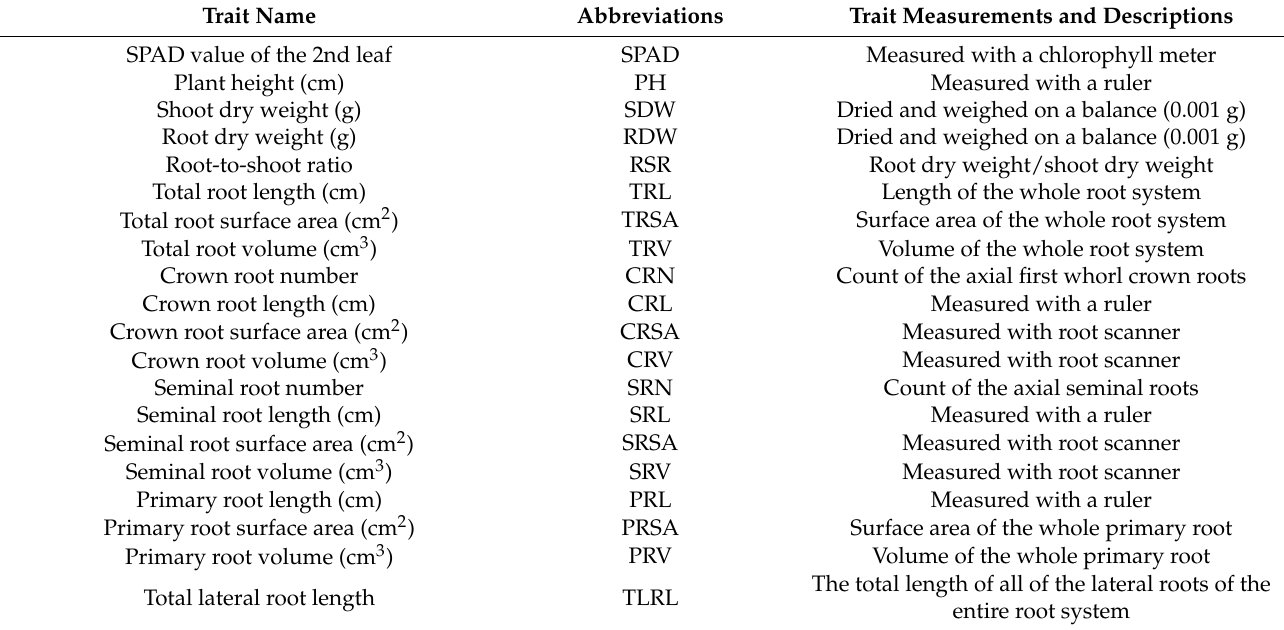
Table 1. Maize seedling trait measurements and